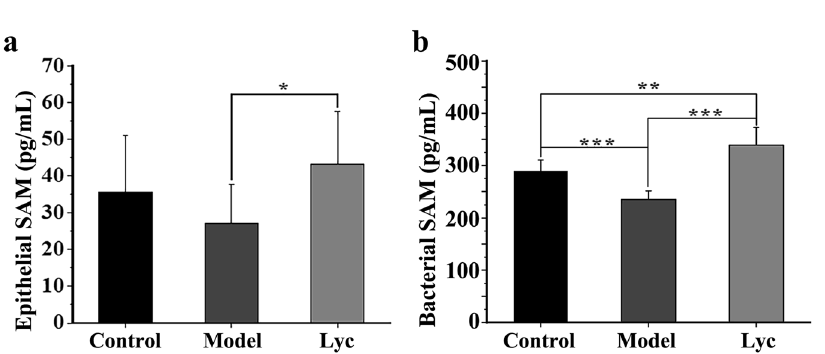
Fig. 6 The contents of S-adenosyl methionine (SAM) of each group. a SAM contents in colonic epithelial tissue and b intestinal contents. The error bars on the bar charts represented the standard deviations. The “ * ” indicated the P value was less than 0.05, “ ** ” indicated the P value was less than 0.01, and “ *** ” indicated the P value was less than